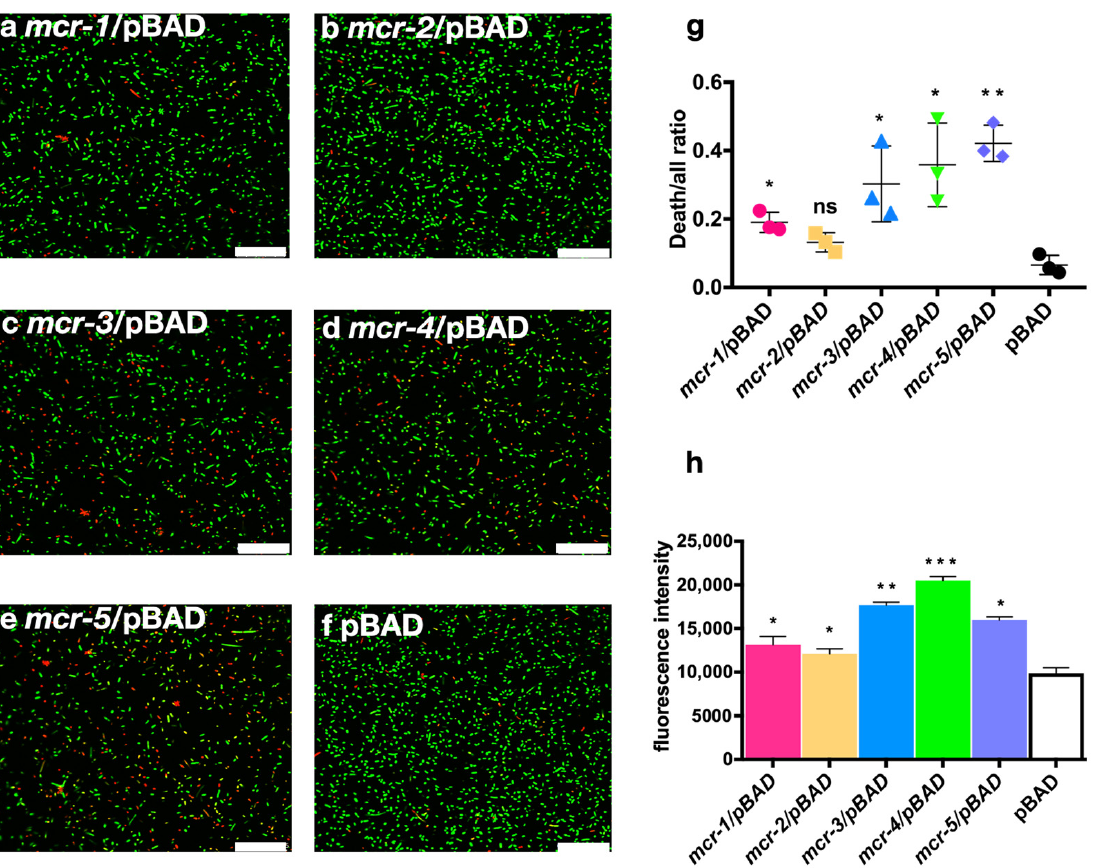
Figure 3. LIVE/DEAD staining of strains expressing MCR genes. ( a – f ) Confocal observation of strains expressing MCR-1–5 with 0.02% L-arabinose induction. ( g ) Statistical analysis of LIVE/DEAD staining images; images were analyzed using ImageJ software. ( h ) Membrane permeability of strains expressing MCR genes. Fluorescence intensity of NPN after 5 min of incubation with strains was detected at 420 nm. * p < 0.05, ** p < 0.01, *** p < 0.001, ns: no significant difference. Scale bars represent 25 μ m.